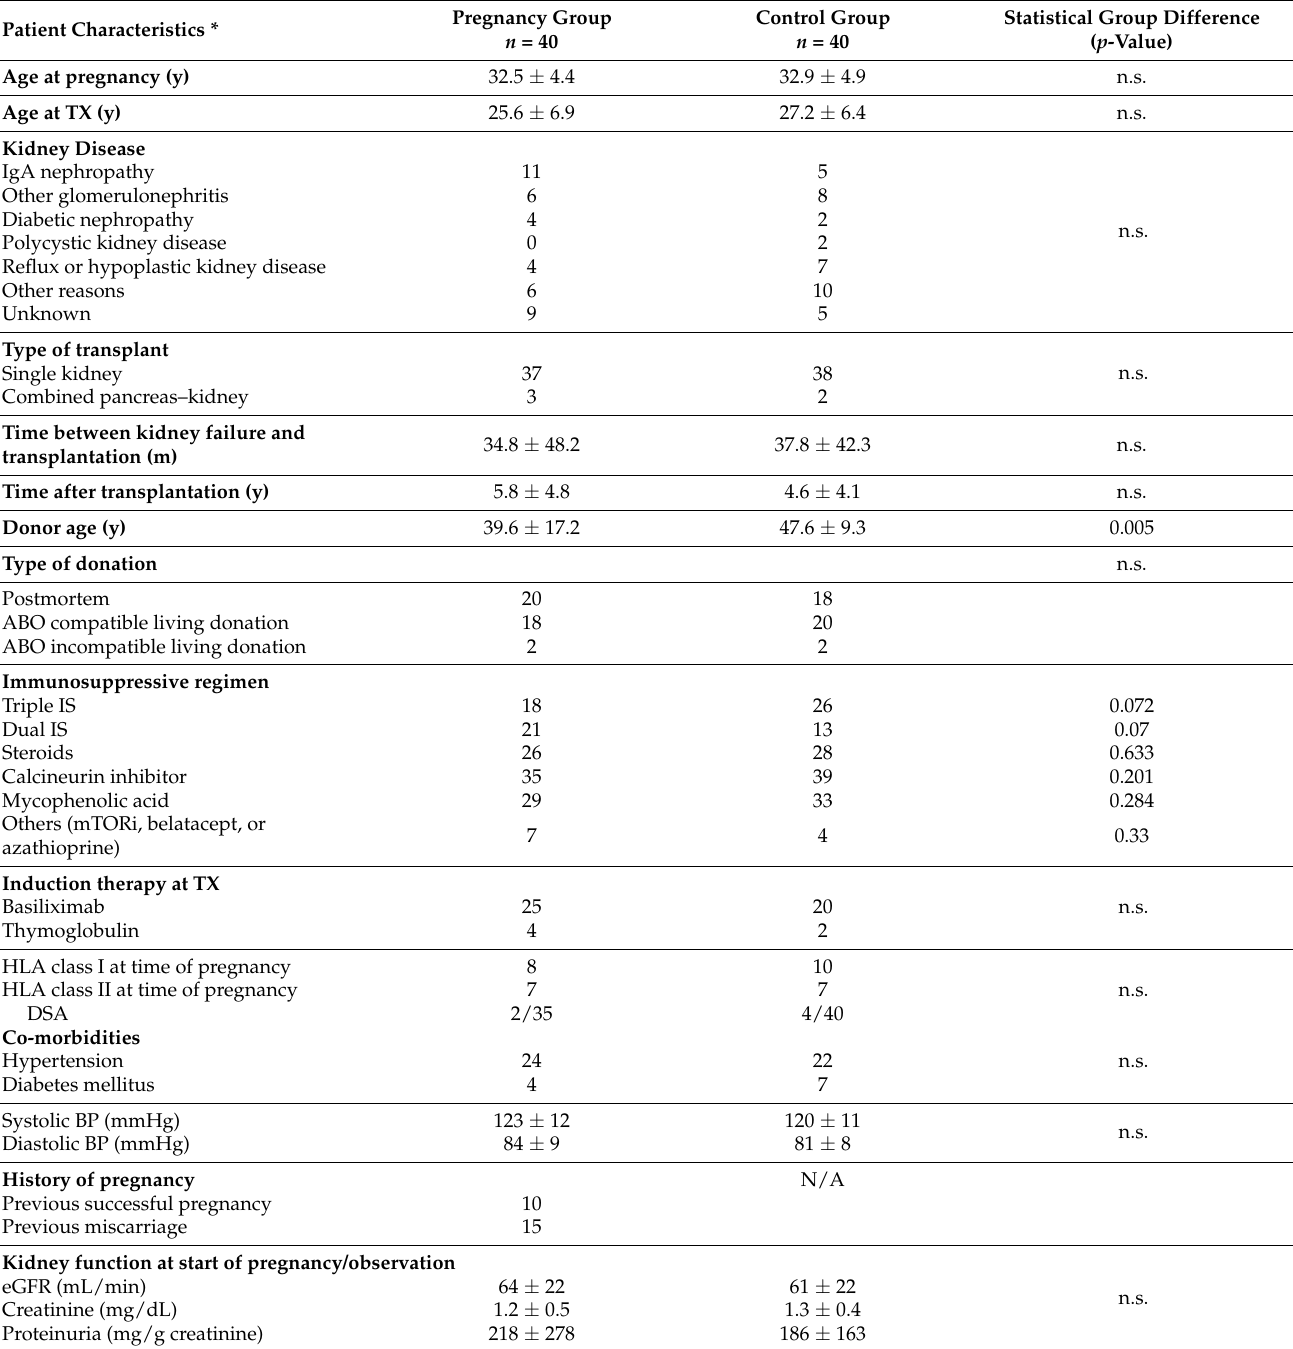
Table 1. Baseline characteristics of KTR with pregnancy matched to a control